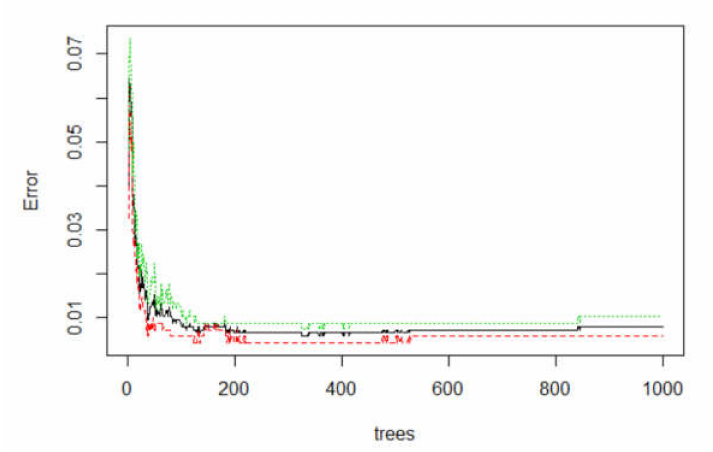
Figure 13. The error rate of the overall RF model (black line: OOB (out of the bag); red line: without landslide; green line: with